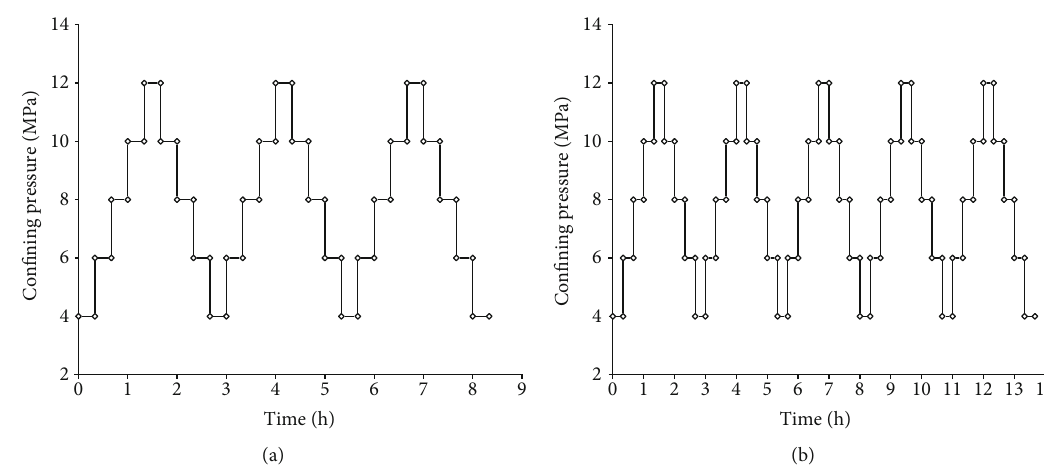
Figure 4: Cyclic loading-unloading path of con fi ning stress for (a) sandstone and (b) granite specimens.